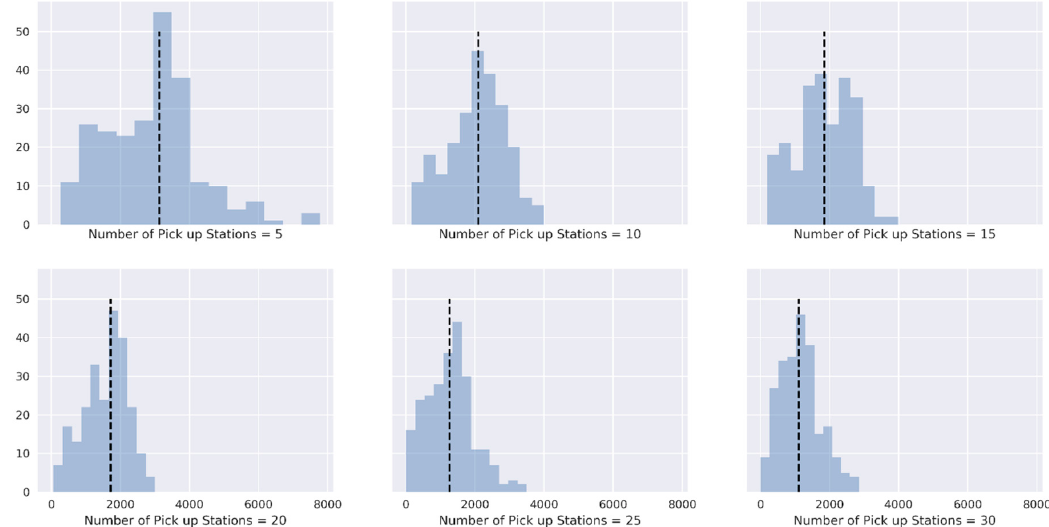
Figure 5. Customer distance to the nearest DC in meters (dashed line represents median value).